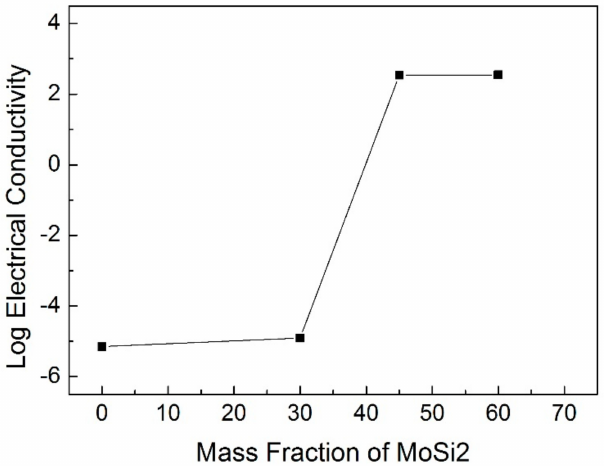
Figure 10. Electrical conductivity of the Si 3 N 4 –MoSi 2 composites as a function of MoSi 2 mass